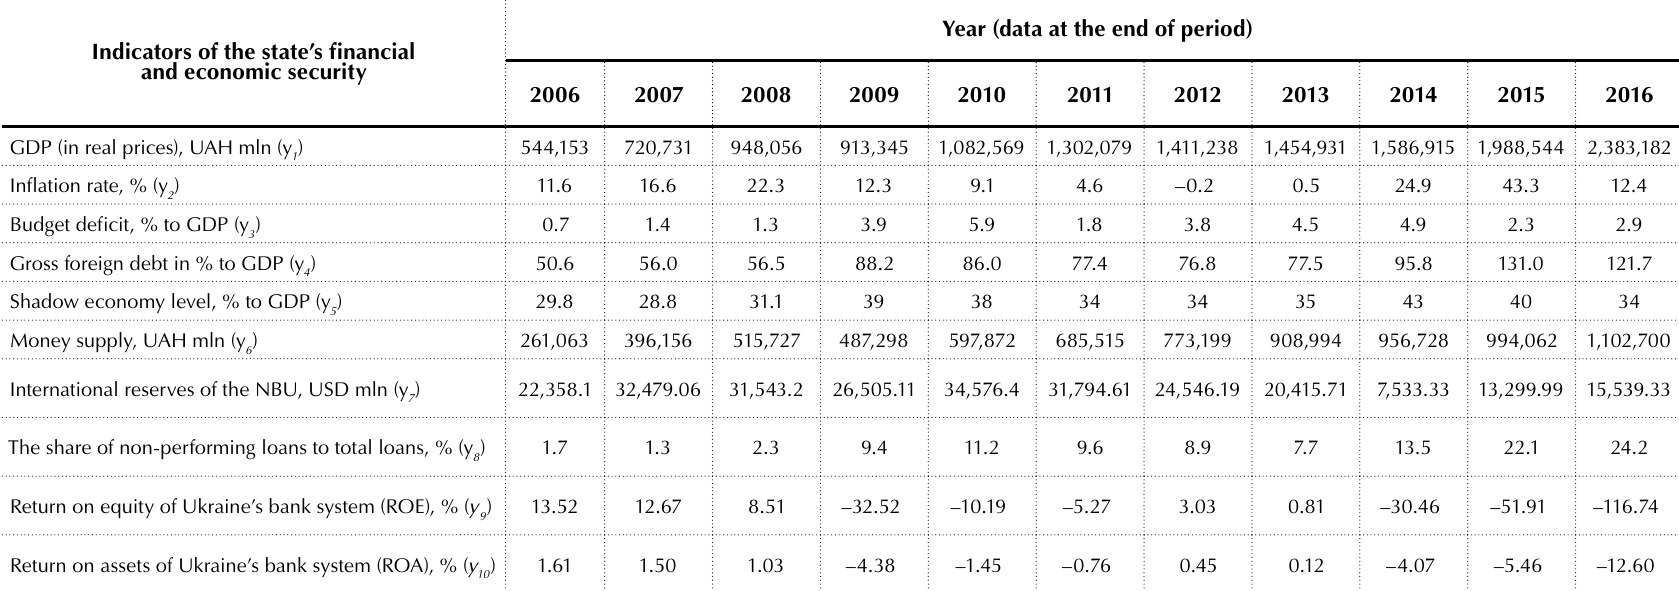
Table 1A. Indicators of the state’s financial and economic security (performance indicators) to be used for the construction of the correlation and regression